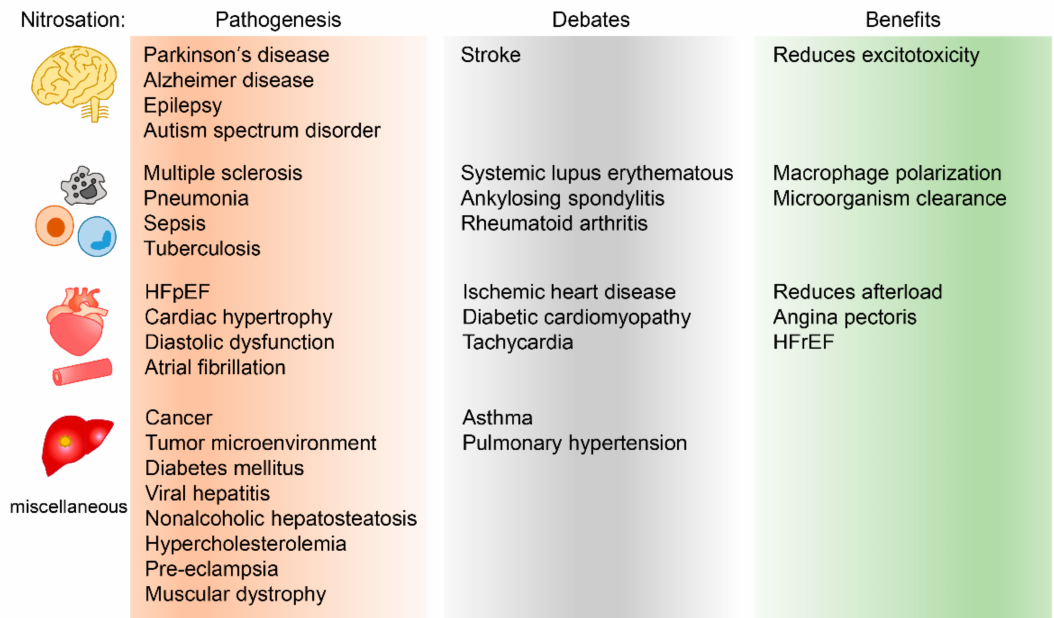
Figure 1. Clinical implications of nitrosation in human disease. HFpEF, heart failure with preserved ejection fraction; HFrEF, heart failure with reduced ejection